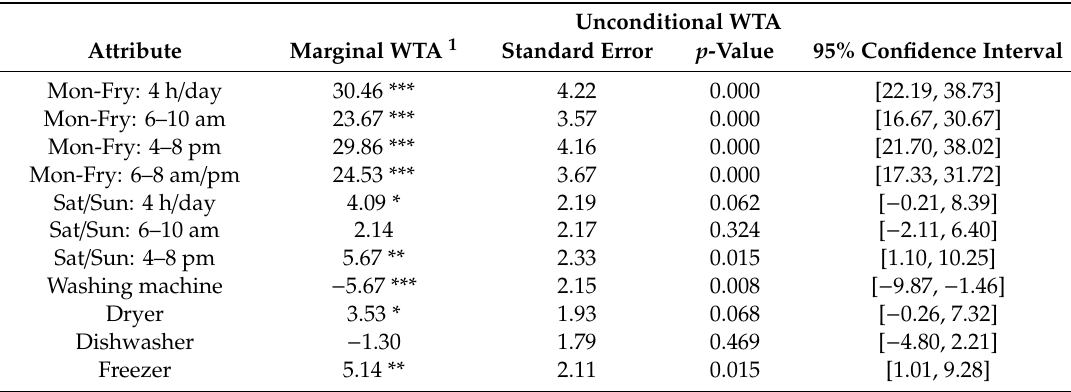
Table 5. Unconditional WTA in € based on MXL